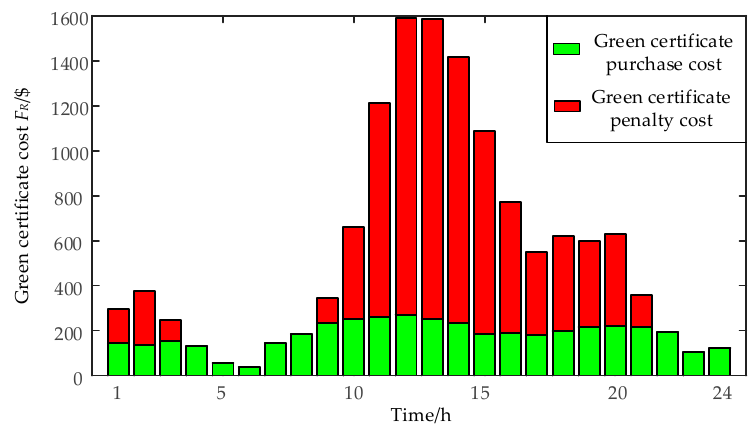
Figure 6. Green certificate in each period. 379